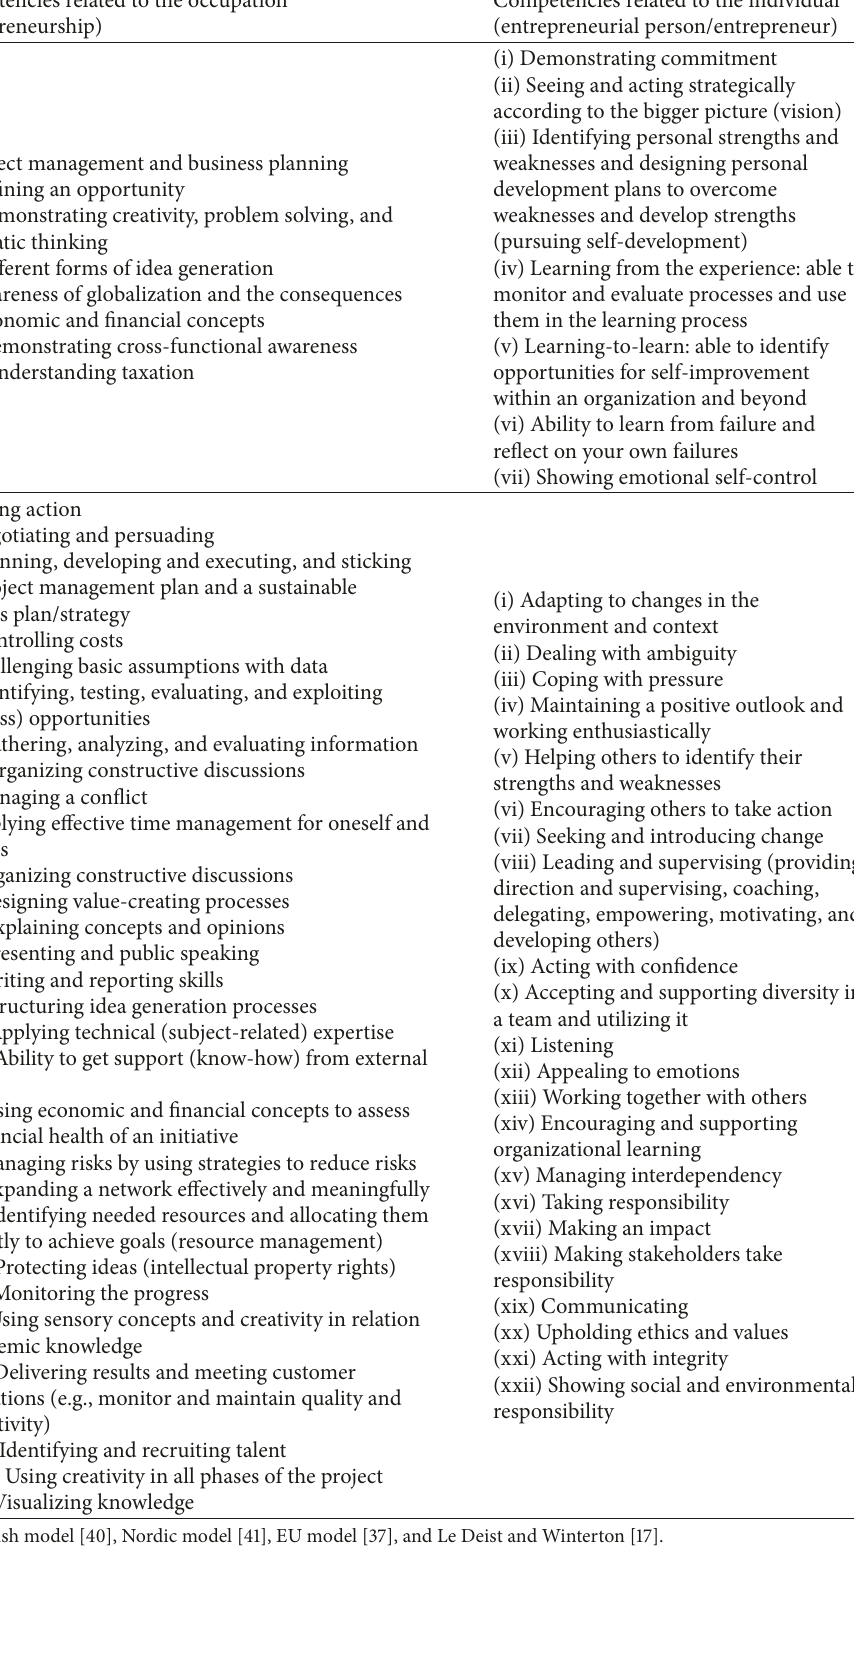
Table 3: Division of competencies based on Le Deist and Winterton [17] classification of entrepreneurial competencies stated in the EE competence models and in the